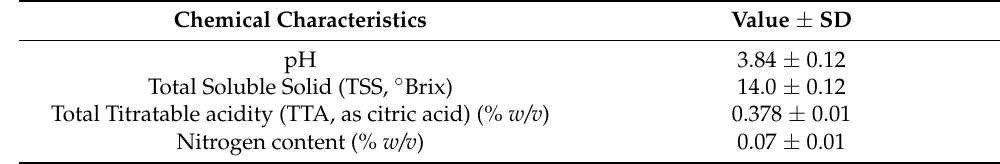
Table 1. Basic chemical characteristics of fresh pineapple juice.